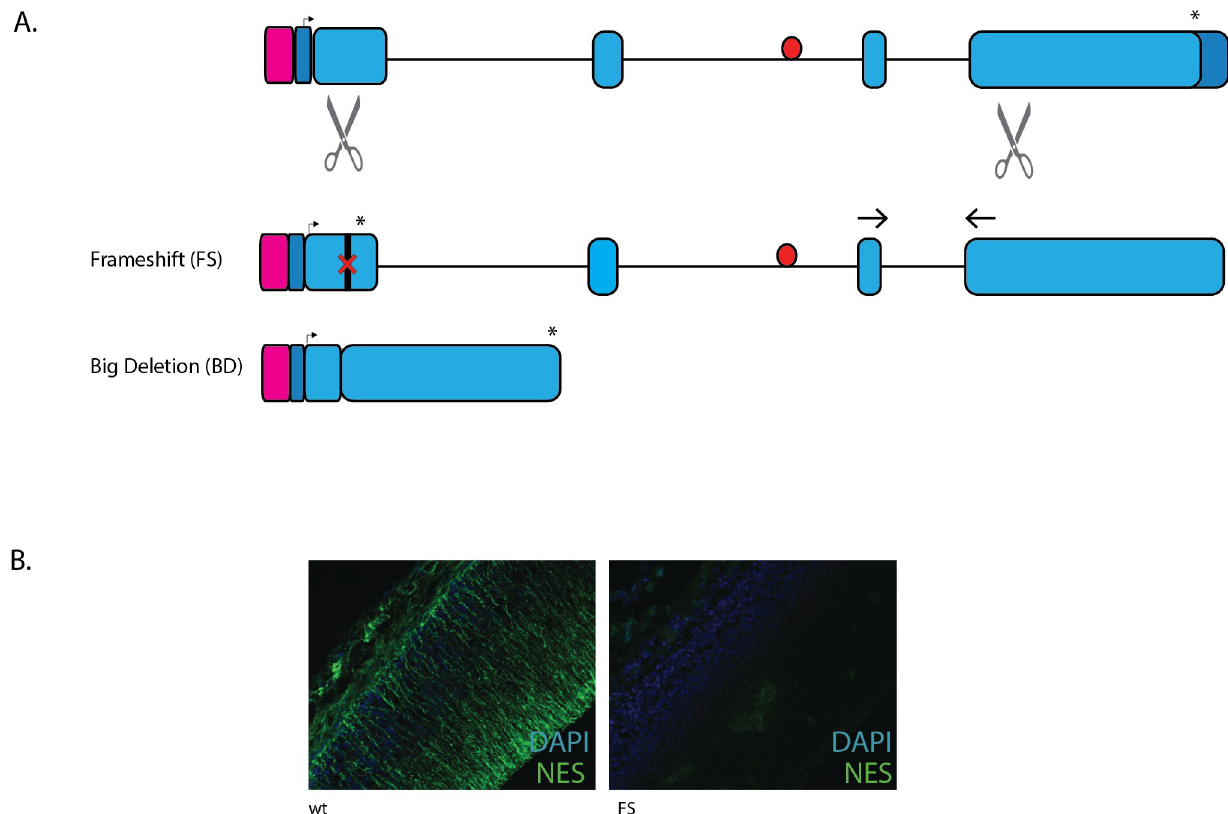
Fig 5. Generation of Nes null mouse lines. A. CRISPR guide sequences (scissors) designed to cut within exon 1 and exon 4 of the Nes gene. The FS allele generated a frameshift mutation at codon 50, while the BD allele removed the 8.7 kb of intervening sequence. qRT-PCR primers indicated by the arrows amplify the FS, WT and -255 alleles. Pink box indicates the promoter, dark blue is 5’ and 3’ UTR, pale blue is coding regions, red circle is Nes enhancer, arrow is transcriptional start site and asterisk is the stop codon. B. Immunohistochemical staining with NES antibody on ‘frameshift’ embryonic cortex shows no detectable protein